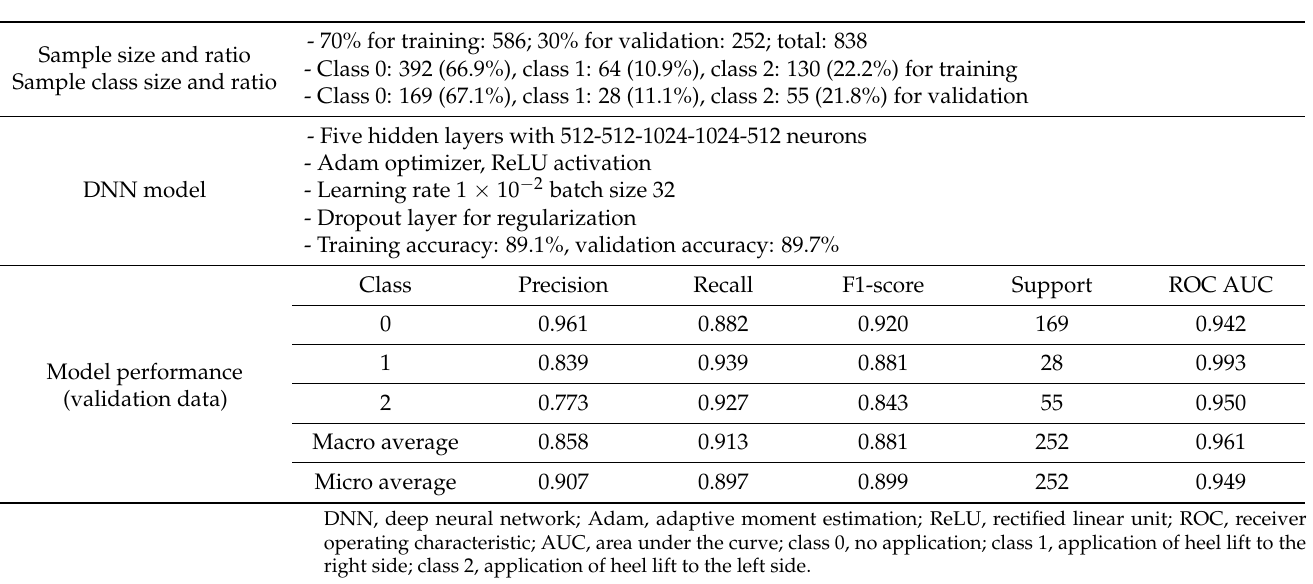
Table 2. Details of the model for determining the application of heel lift.